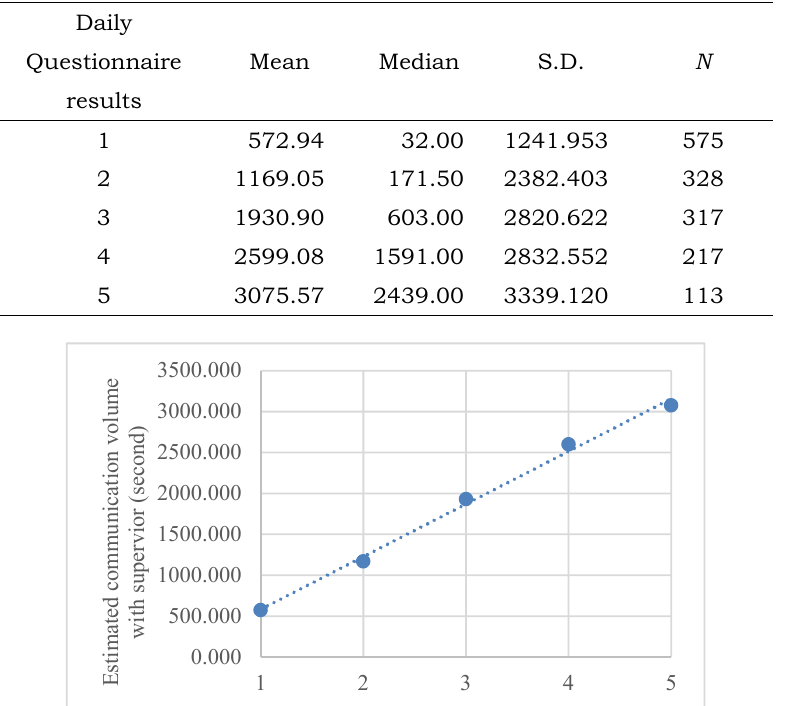
Table 1. Basic statistics for each group of daily questionnaire results Daily